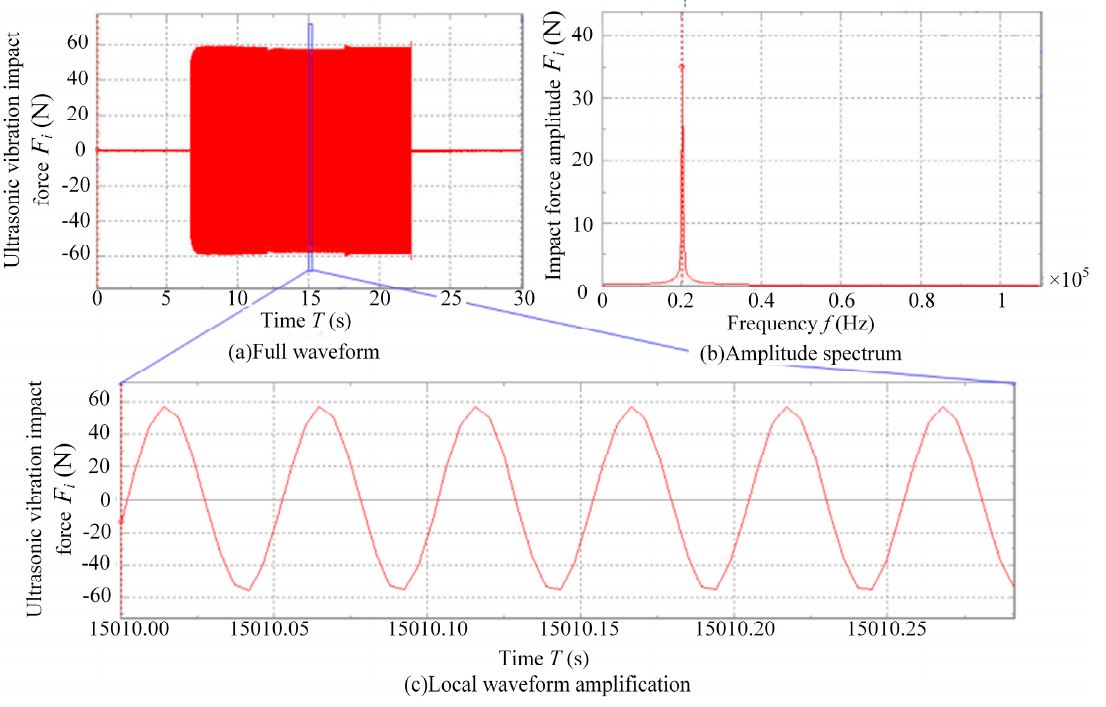
Figure 6. Impact forces of ultrasonic vibration without drilling. ( f = 20 KHz, A = 2.2 µ m, Sampling